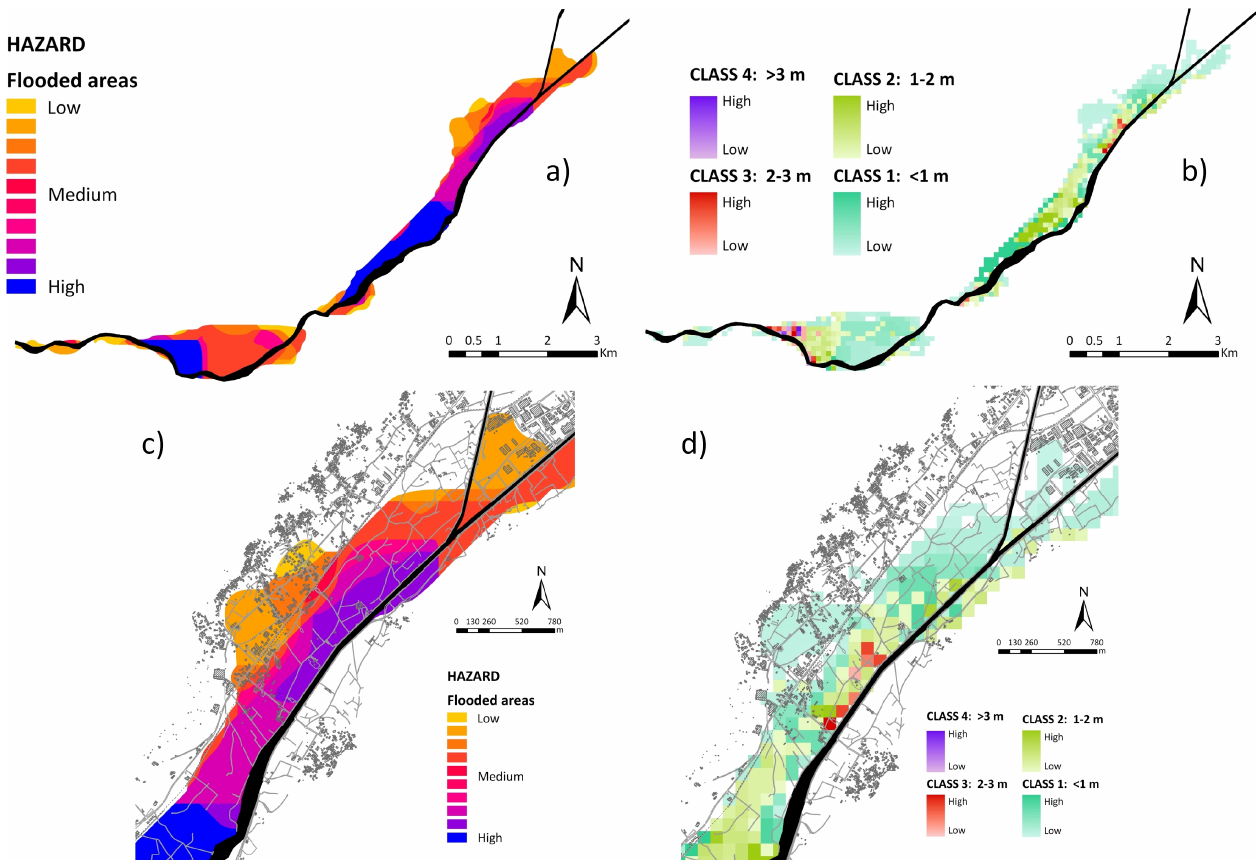
Fig. 5. Representation of flood hazard Map 1 (a) and Map 2 (b) , with details (c–d)